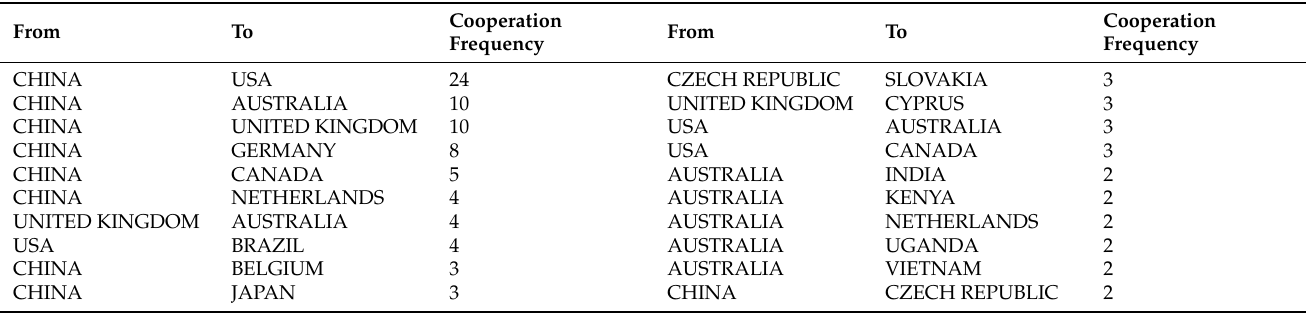
Table 3. Main nations China cooperated within the field of land consolidation and rural revitalization from 1950 to 2021.